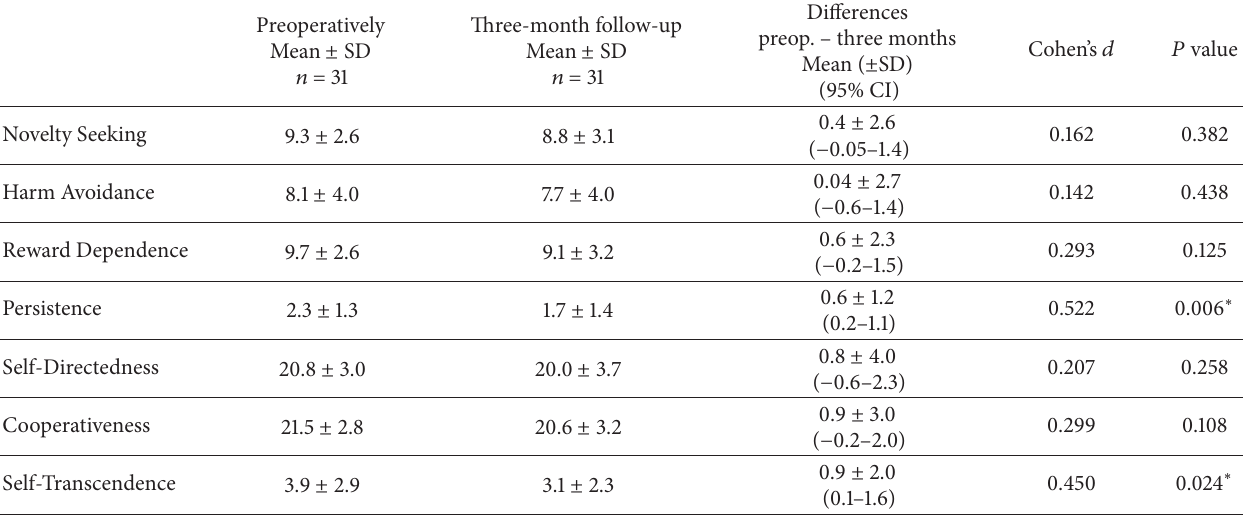
Table 3: Comparison of TCI subscale scores preoperatively and at three-month follow-up using the paired samples 𝑡